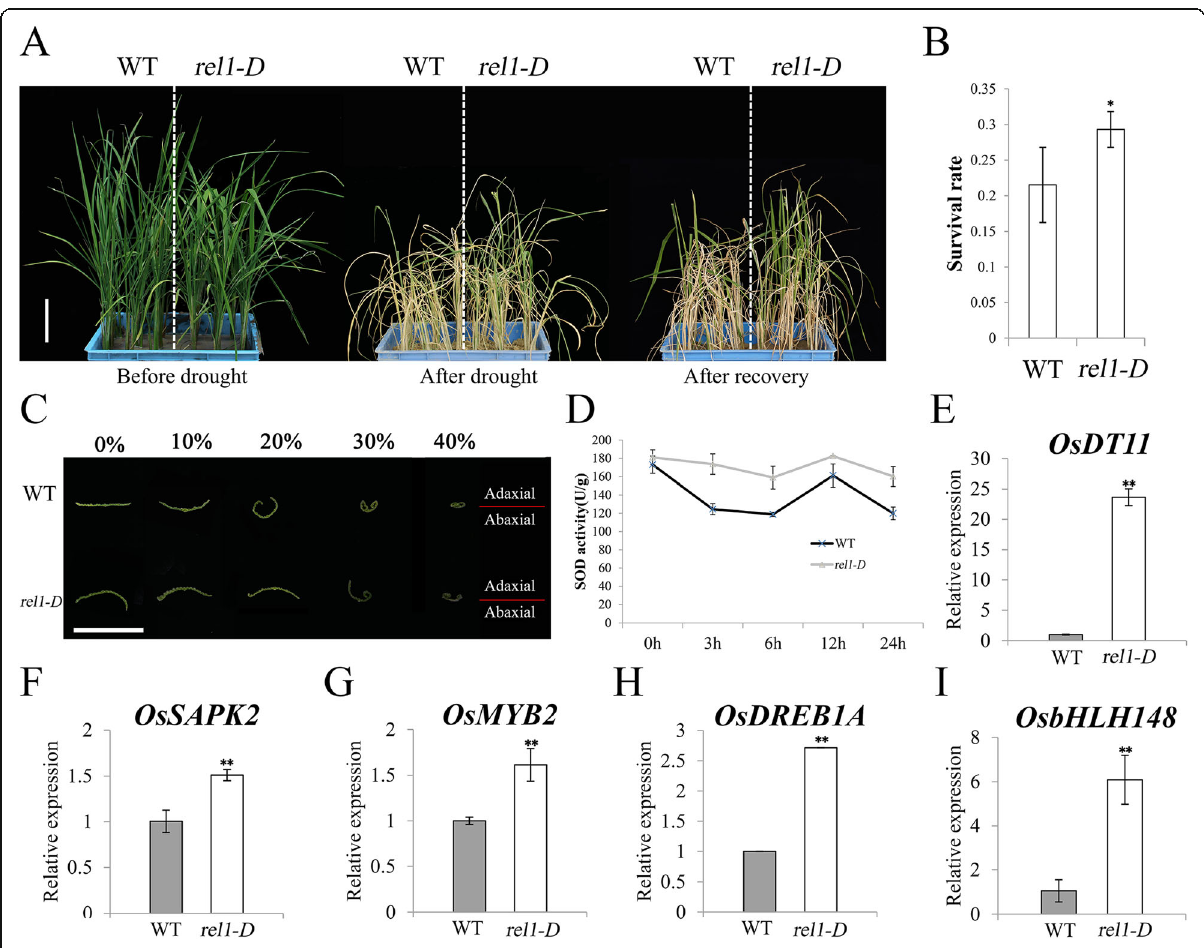
Fig. 1 Response of rel1-D to drought stress. a , Phenotype of WT and rel1-D with drought treatment. Two-month-old seedlings were used, bars=10 cm. b , Survival rate of WT and rel1-D were derived from the (A). c , Third leaf stage seedling of WT and rel1-D were treated by different concentration of PEG, bars=5 mm. d , Measurement of SOD activity in wild type and rel1-D . E-I, Expression of drought-responsive genes in wild type and rel1-D . b and e - i , Data were presented as mean±S.E., * p -value <0.05, ** p -value <0.01, two-tailed, two sample Student ’ s t